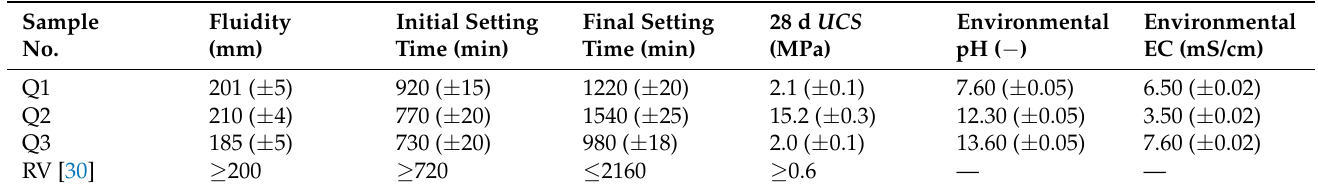
Table 3. The fresh and hardened performances of backfill paste and